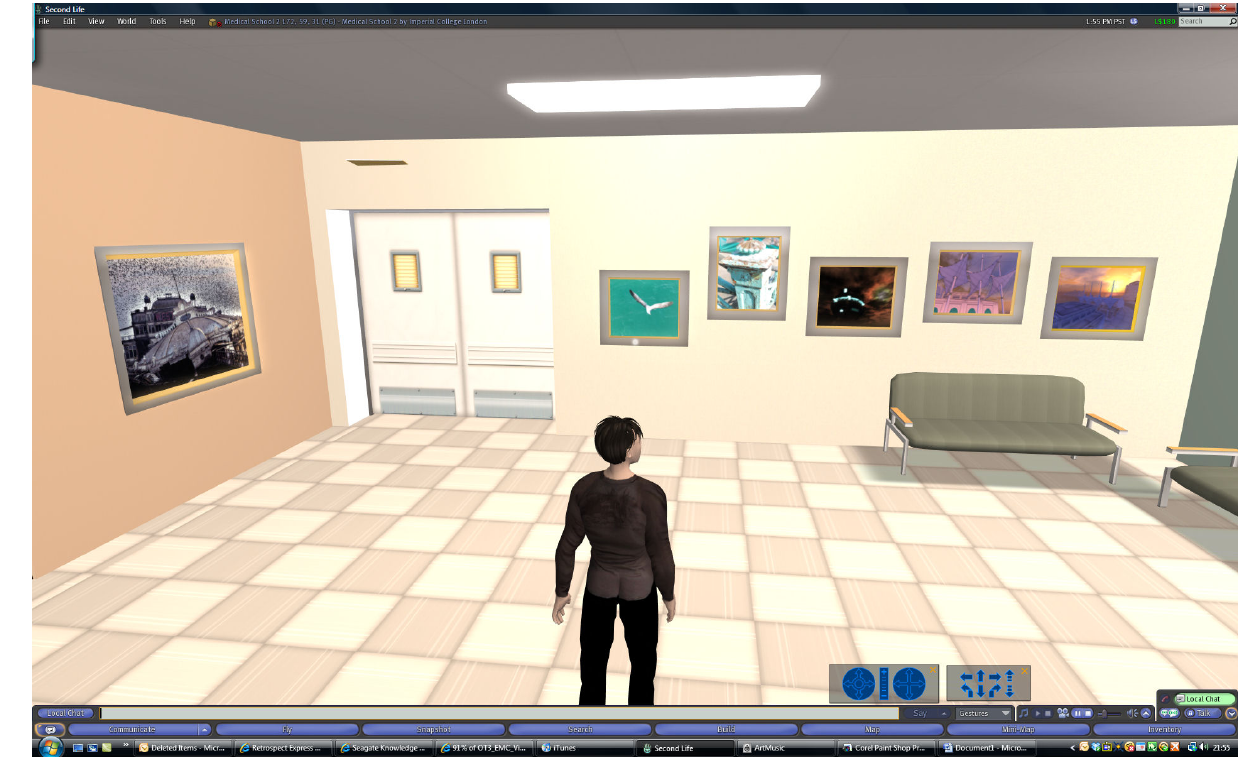
Figure 3. Screenshot of clinical examination